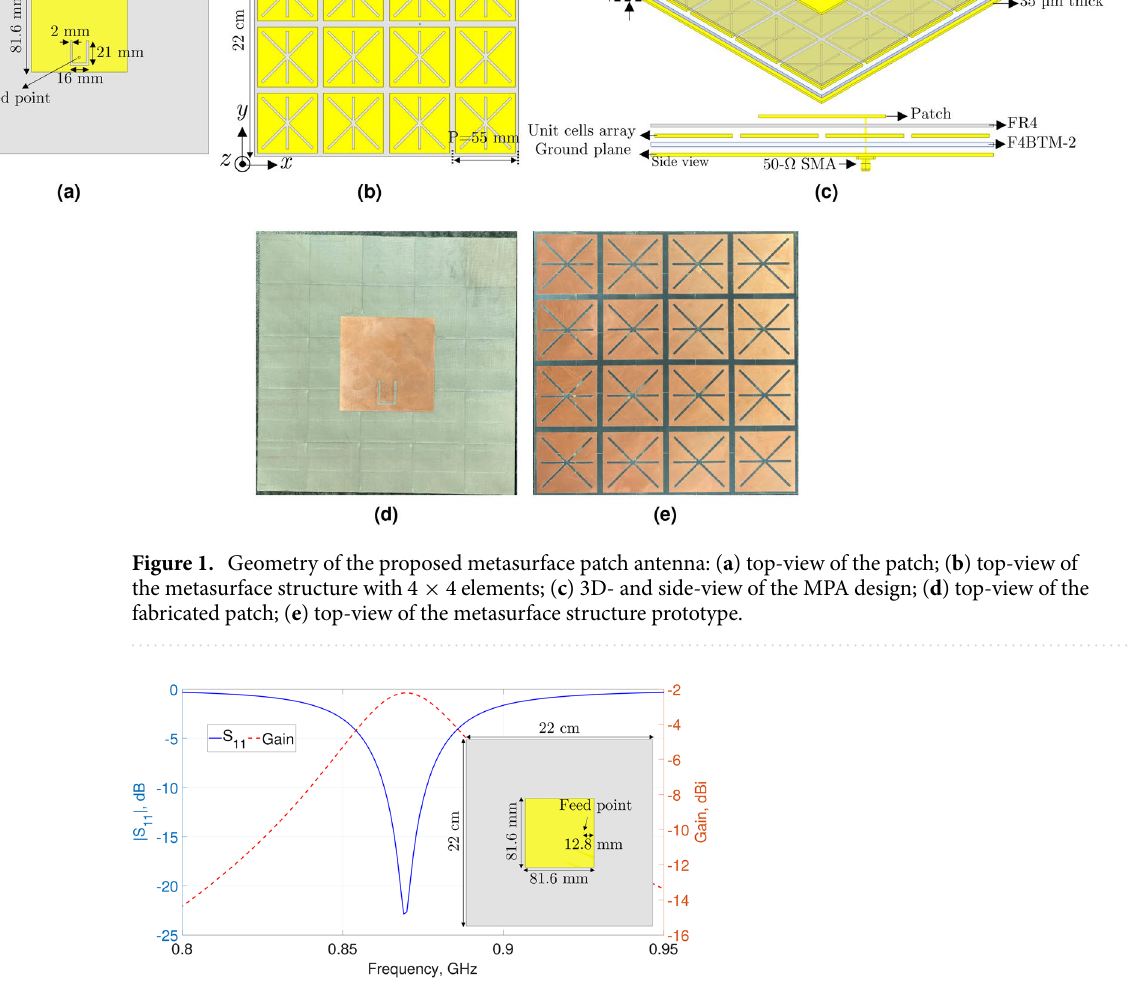
Figure 2. Simulated